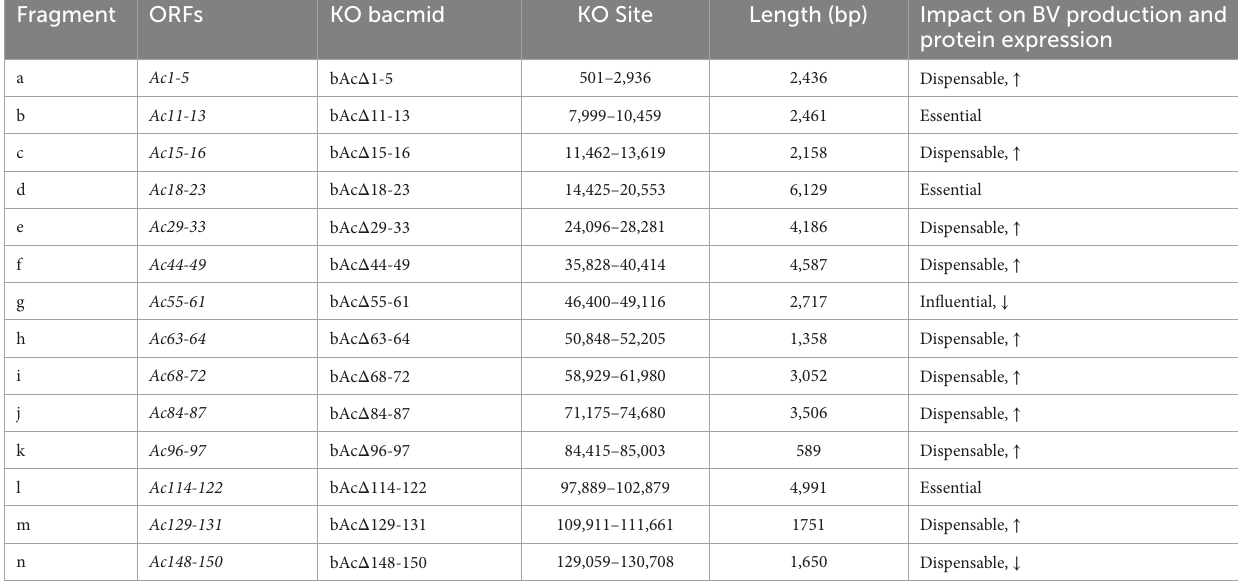
TABLE 2 Summary of the impact of the knockout of 14 DNA fragments on AcMNPV BV production and protein expression.